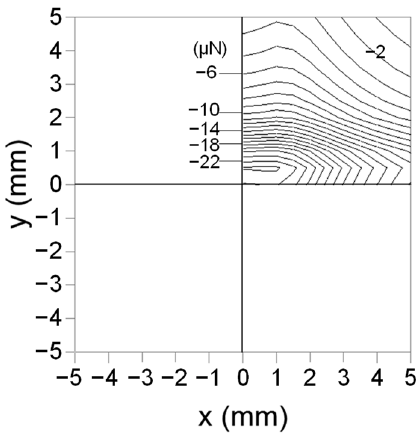
Figure 11. Vertical component of the electrostatic force, F z .